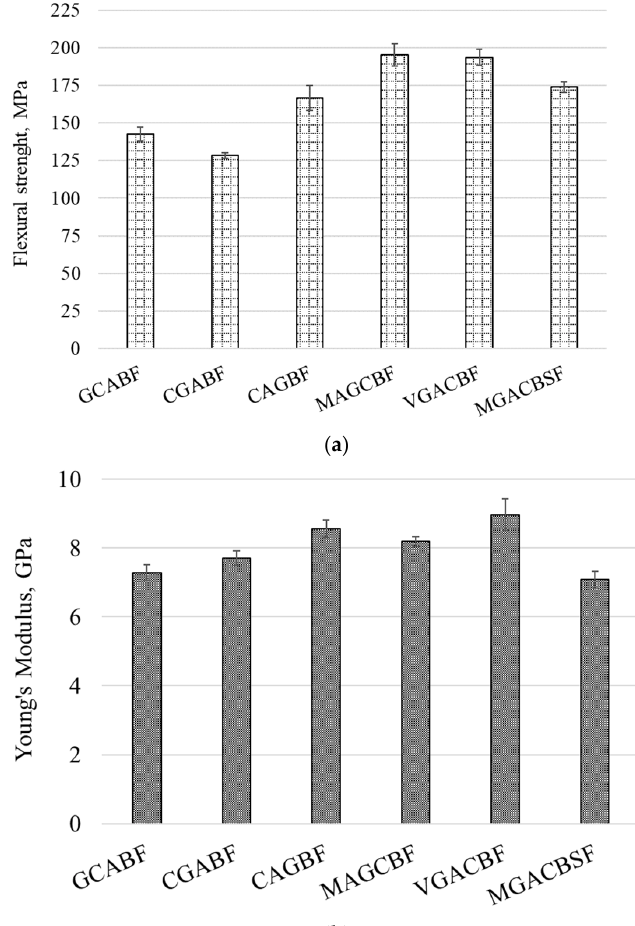
Figure 3. Flexural strength ( a ) and Young’s Modulus ( b ) results of EP ‐ composites obtained from the flexural test.